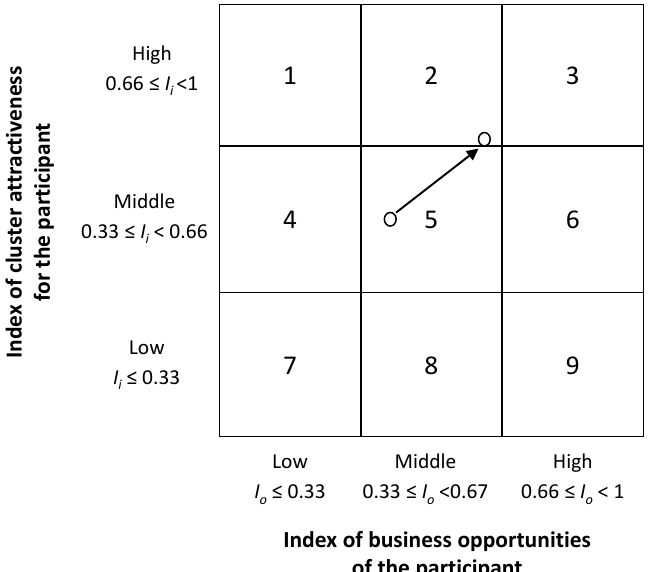
Figure 4. The matrix of the interaction intensity of the tourism cluster subjects with the “entrepreneurial opportunities – the attractiveness of the cluster